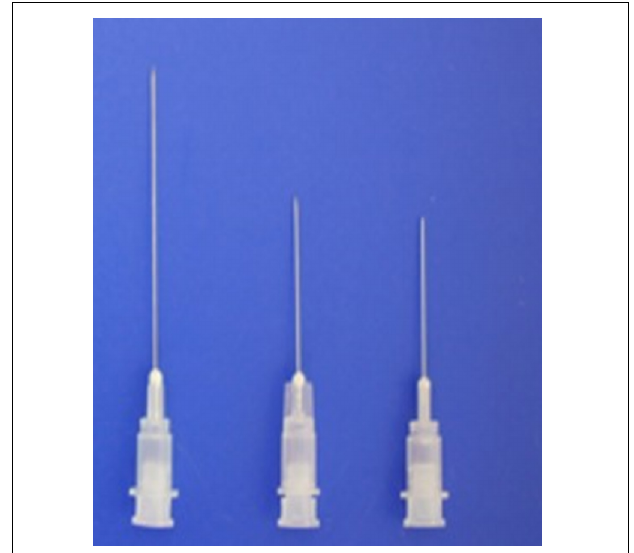
of the mastoid process, above the lowest point of the earlobe ( Figures 4A,B